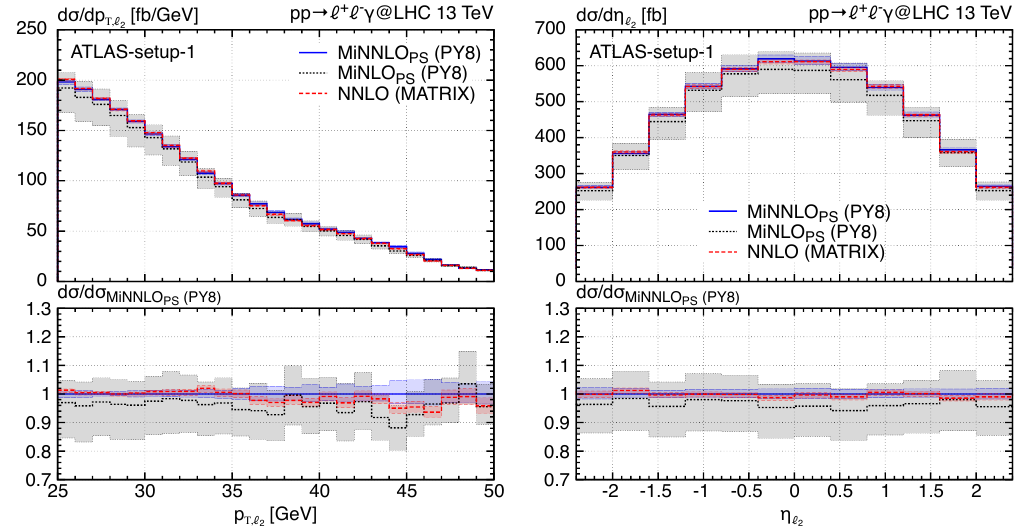
Figure 8. Distribution in the transverse momentum (left plot) and in the pseudorapidity (right plot) of the second-hardest lepton for MiNNLO and NNLO (red, dashed